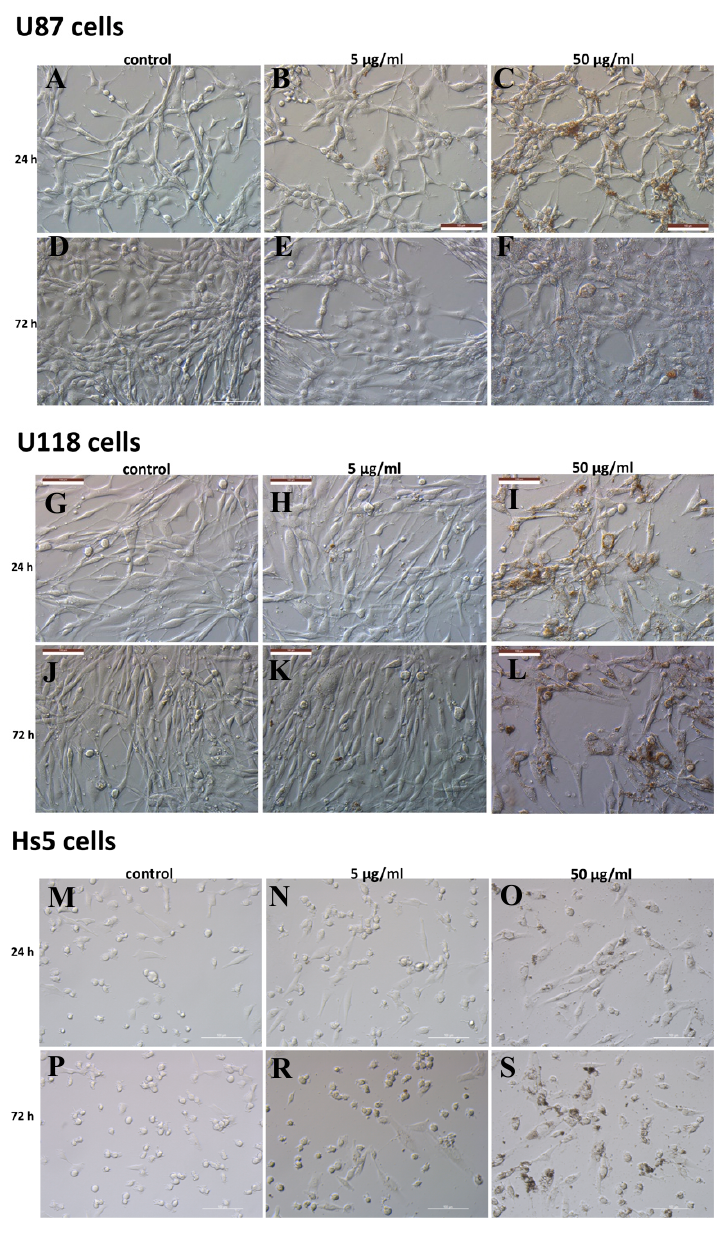
Figure 2. Morphological changes in U87 ( A – F ), U118 ( G – L ) glioblastoma cells, and Hs5 stromal cells ( M–S ) after treatment with 5 and 50 µ g / mL concentrations of diamond nanoparticles (NDs). Represents control cells ( A , D ; G , J ; M , P ) that did not undergo treatment. Scale bar represents 100 µ m. The viability of the U87, U118, and Hs5 cells was examined using the 3-(4, 5-dimethylthiazolyl-2)-2, 5-diphenyltetrazolium bromide (MTT) assay (Figure 3). The treatment with 50 µ g / mL concentration of ND for 24 and 72 h significantly reduced the viability of the U87 cells by 20 and 38% and that of the U118 cells by 16 and 30%. In Hs5 cells after incubation with 50 µ g / mL concentration of ND for 24 and 72 h, viability was reduced by 24 and 19%, respectively.